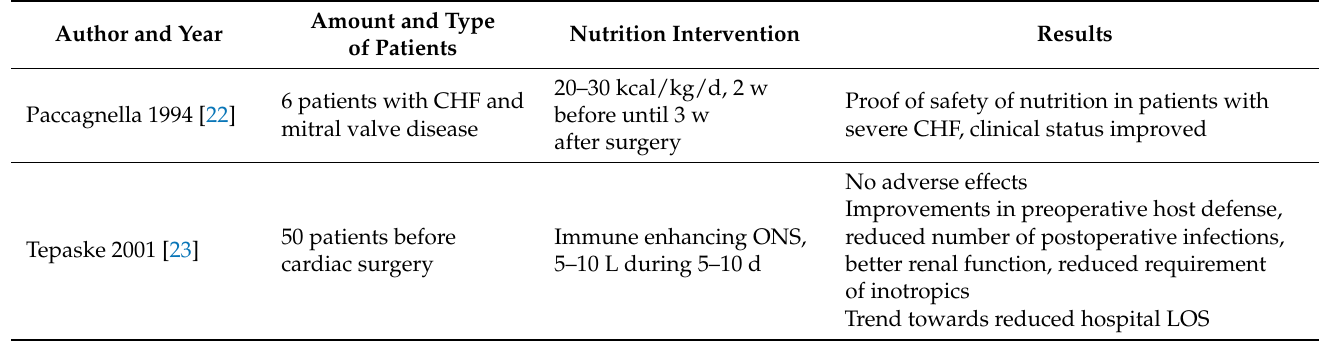
Table 1. Studies addressing preoperative oral nutrition supplements in cardiac surgery and